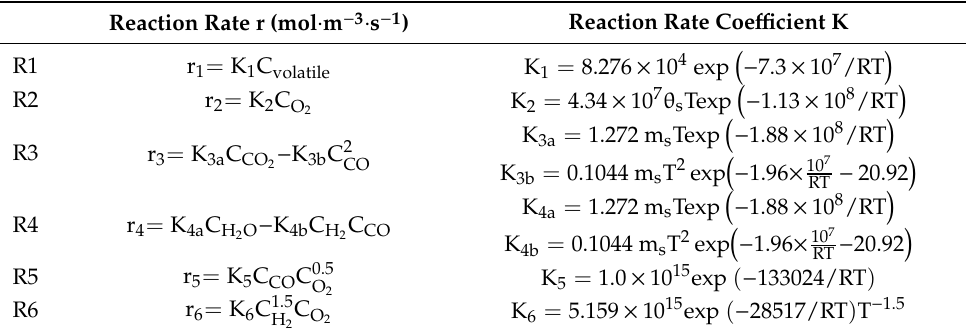
Table 4. Reaction rate and reaction rate coe ffi